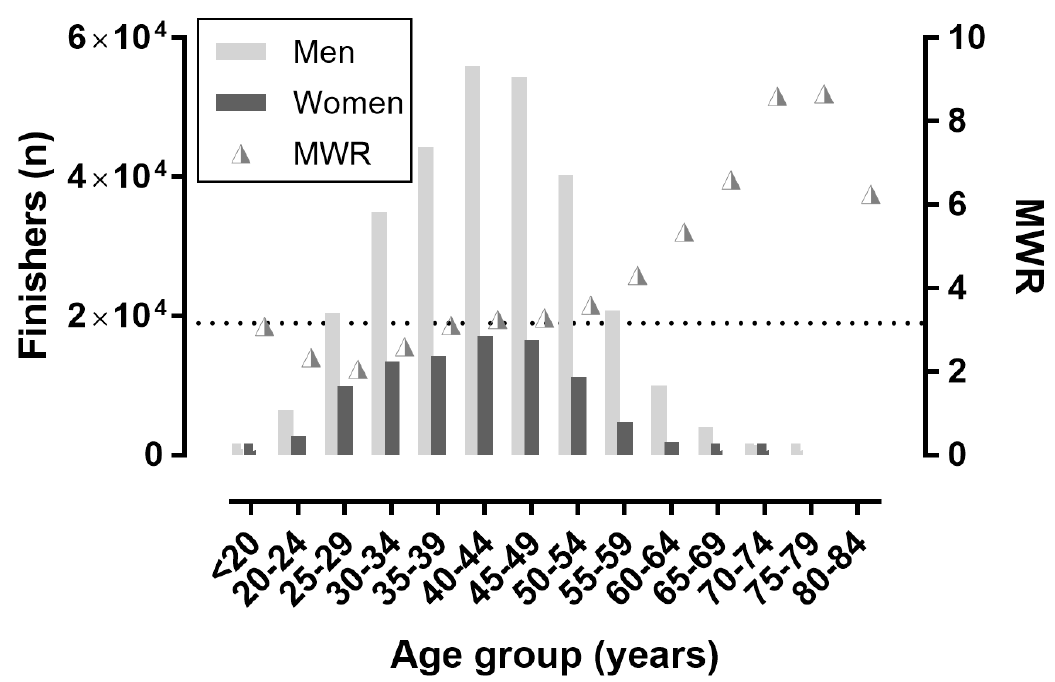
Figure 4. Finishers by 5-year age groups. MWR = men-to-women ratio. The horizontal dashed line shows the overall MWR.